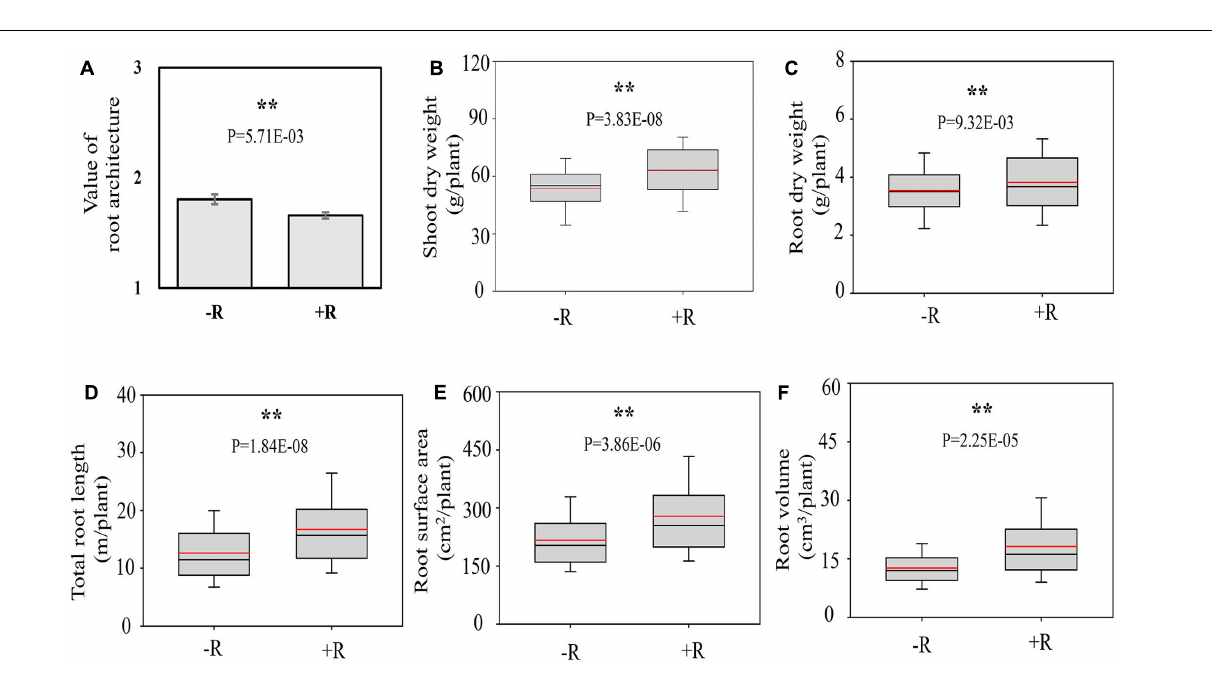
Frontiers in Plant Science |